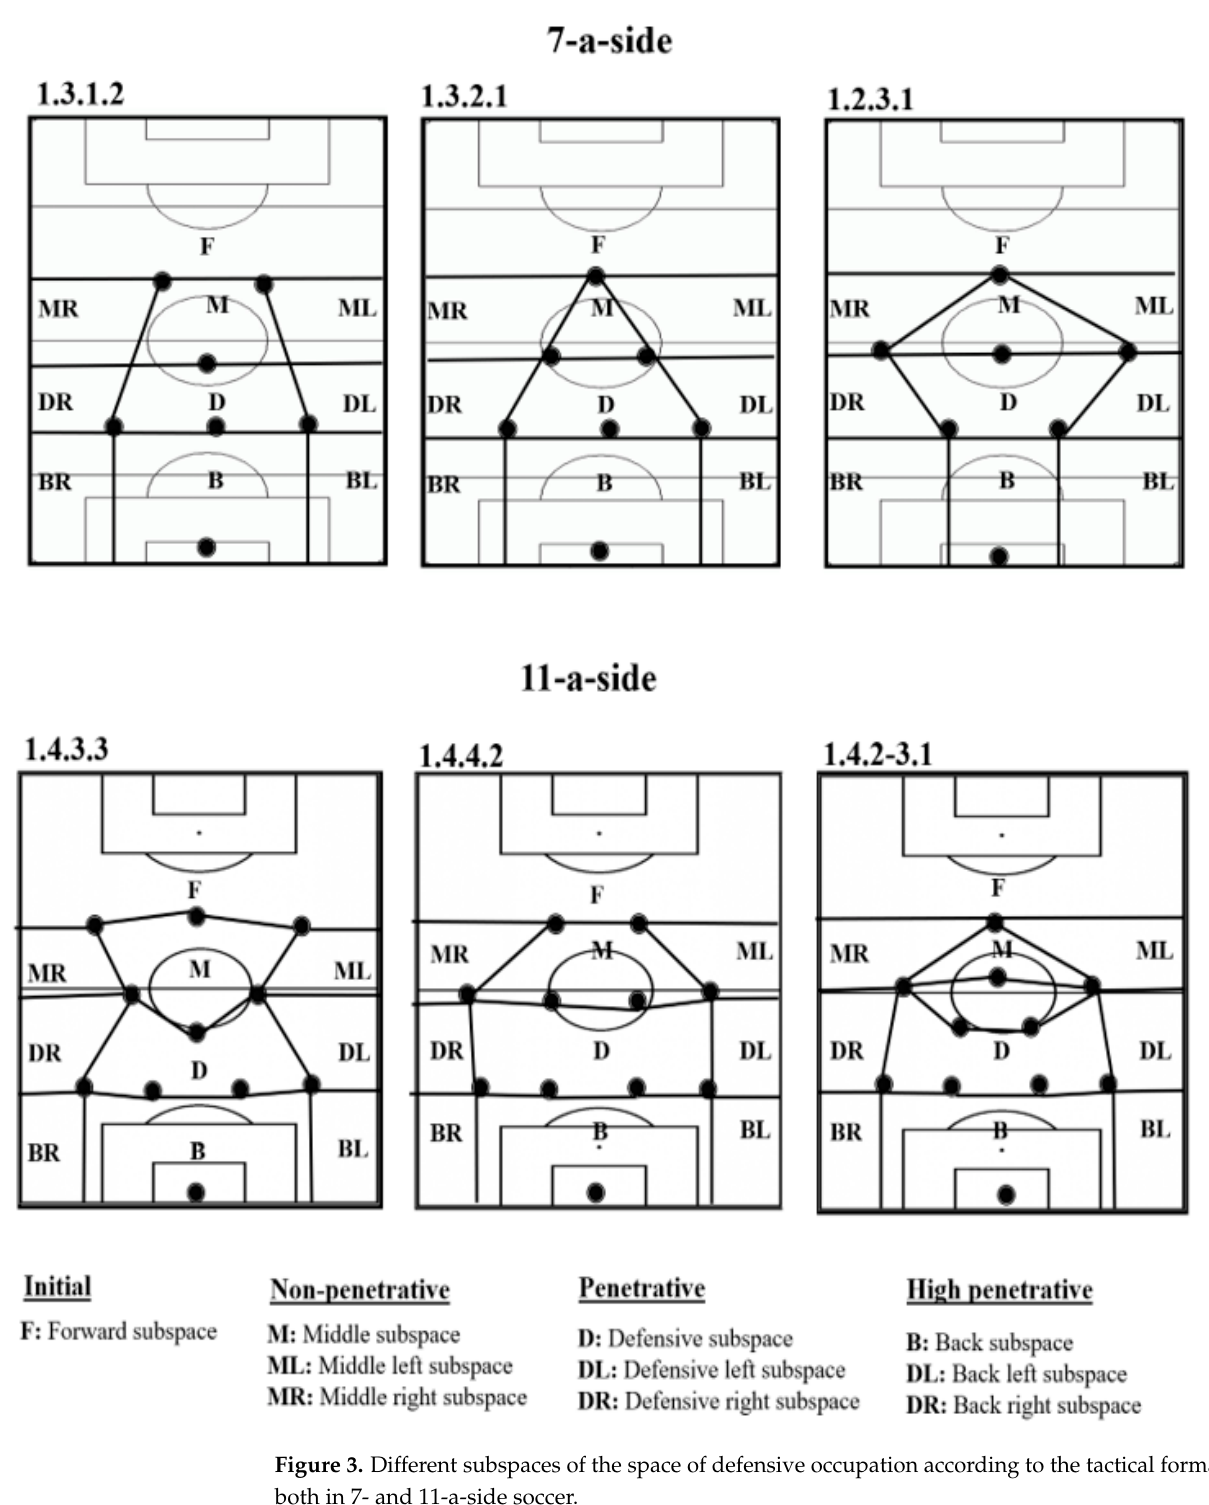
Figure 3. Different subspaces of the space of defensive occupation according to the tactical formation both in 7- and 11-a-side soccer.